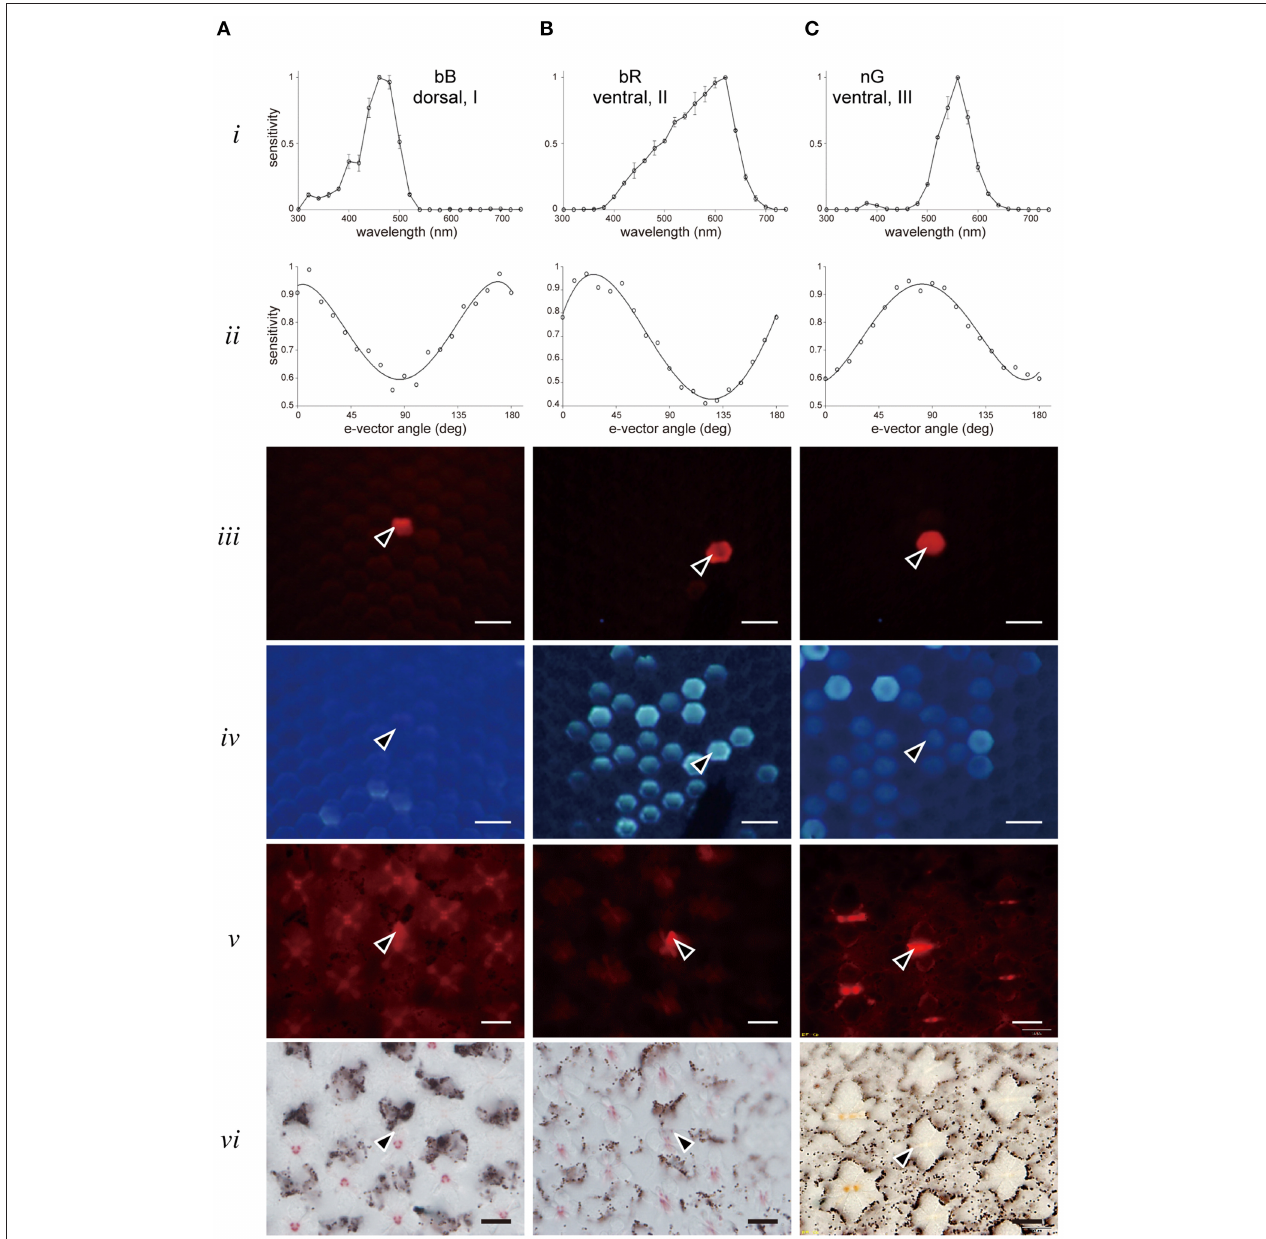
FIGURE 4 | Examples of recorded and localized photoreceptors. (A) A bB receptor in a dorsal type I ommatidium. (B) A bR receptor in a ventral type II ommatidium. (C) A nG receptor in a ventral type III ommatidium. Top two rows show the spectral sensitivity (row i ) and polarization sensitivity (row ii ). Rows iii and iv show the correlation of Alexa fluor-injected receptor observed under green excitation (row iii ) with fluorescence ommatidia observed under UV excitation (row iv ). Rows v and vi show the same section of stained photoreceptor (arrowhead) in the ommatidial array observed under green excitation (row v ) and normal transmission illumination (row vi ). Scale bar 20 µ m.